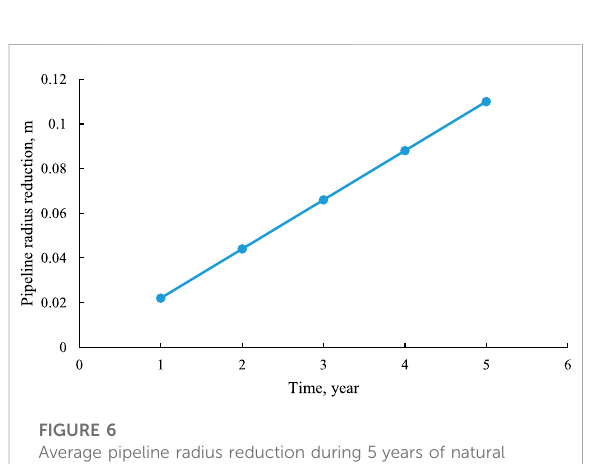
FIGURE 6 Average pipeline radius reduction during 5 years of natural gas